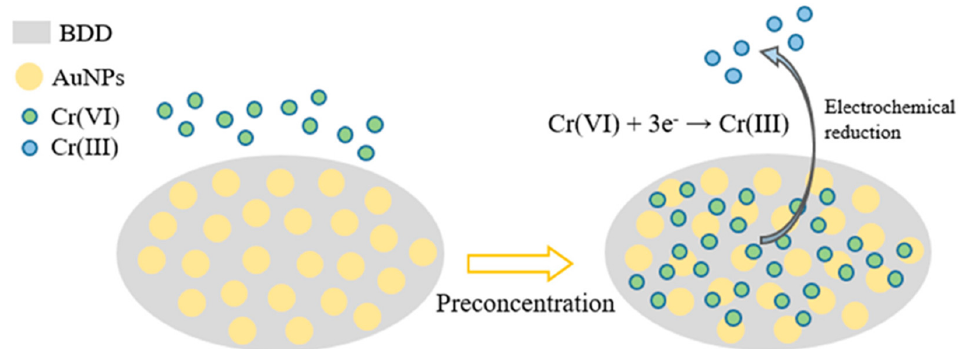
Figure 7. Working principle of Cr (VI) detection by gold nanoparticles (AuNPs)–boron-doped diamond (BDD) electrode (reproduced with the permission of [79]).